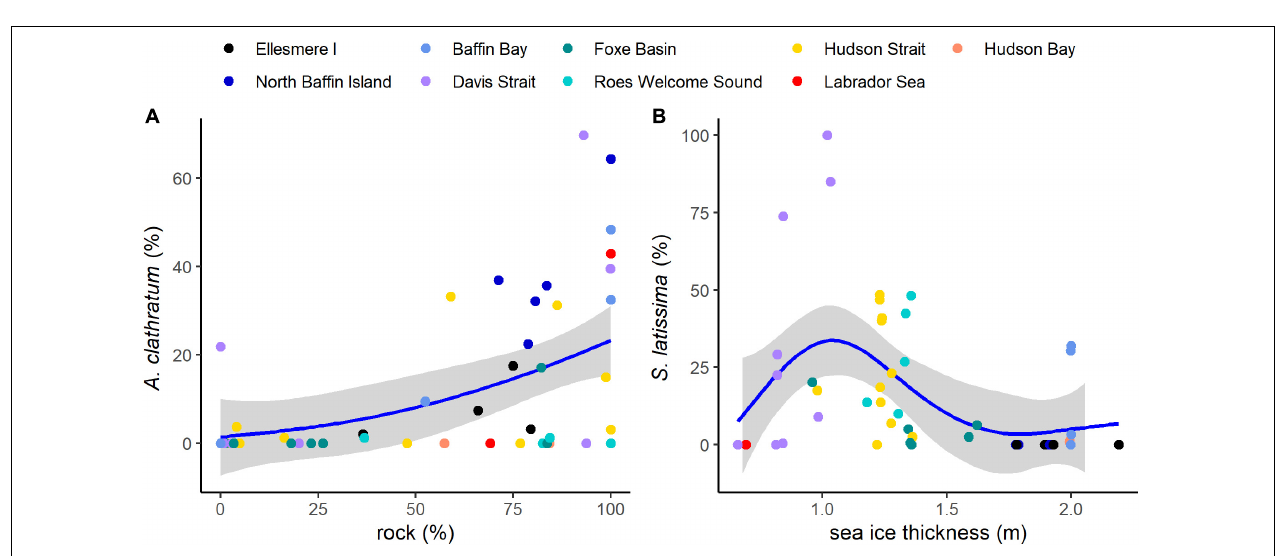
FIGURE 5 | Relationships between (A) percent cover of Agarum clathratum and substrate (% rock), for each site, and (B) percent cover of Saccharina latissima and sea ice thickness. Colors of points show regions. Blue lines are single predictor Generalized Additive Models (GAMs) with 95% CI in gray shading.